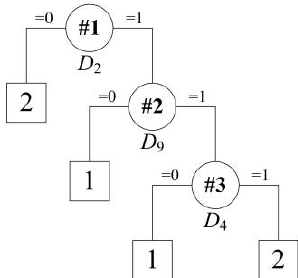
Figure 4. Tree structure for rule extraction on the dataset with correct classifications using only discrete attributes.